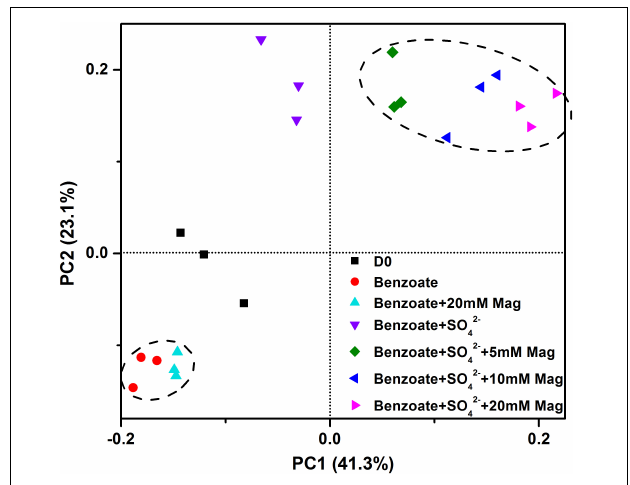
FIGURE 6 | Principal coordinates analysis (PCoA) of microbial communities from sediments incubations of sulfate-dependent benzoate degradation in the presence and absence of magnetite, the sulfate-free control incubations and microbial inocula based on the weighed unifrac distance. Mag denotes